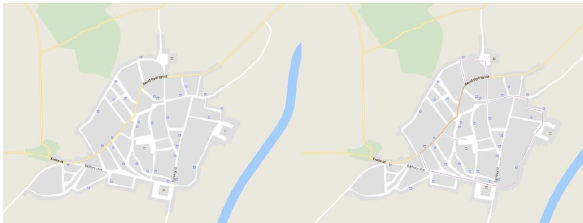
Figure 2. The maps used in the experiment